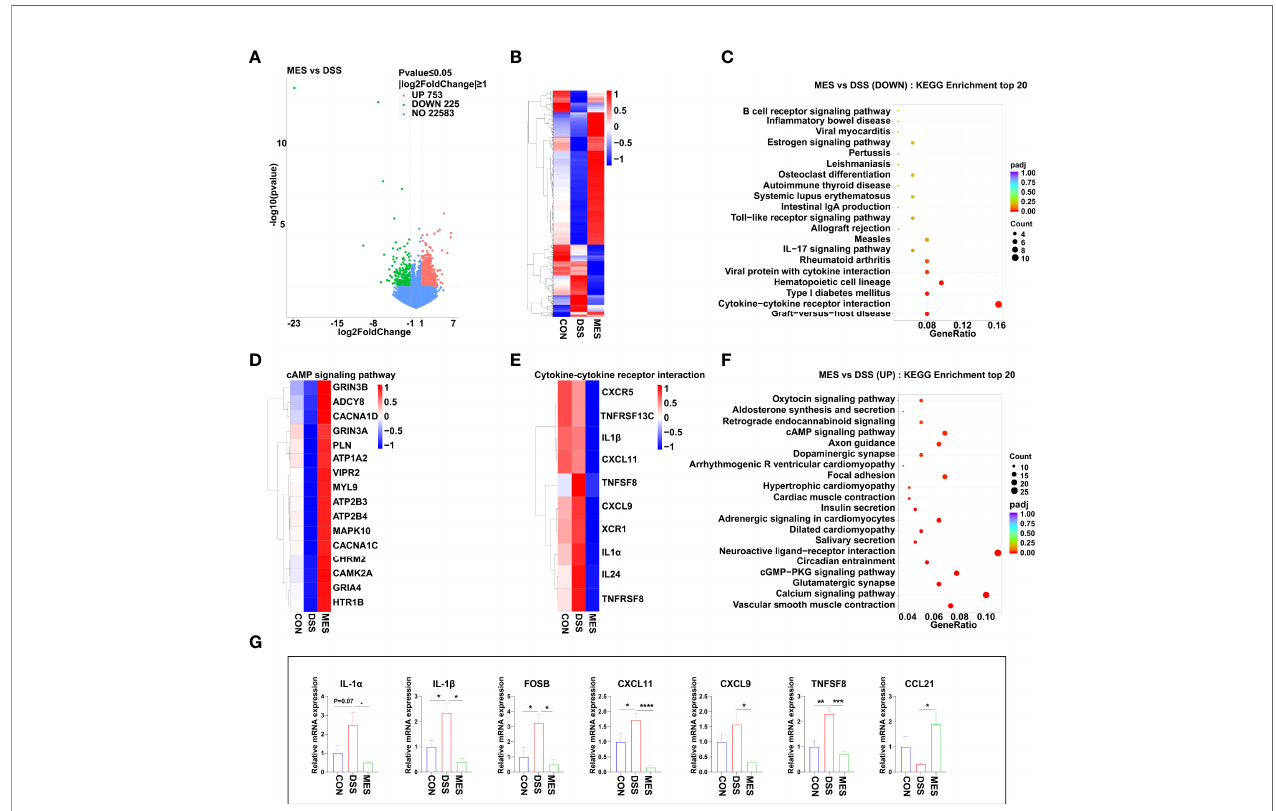
FIGURE 2 | MES suppresses immune responses in piglets with DSS-induced colitis. (A) Volcano plot of DEGs between DSS and MES groups. The X-axis represents the fold change in the expression of DEGs, and the Y-axis represents the statistical signi fi cance of the fold change. Each point represents a DEG. (B) Cluster heatmap of DEGs; top 20 KEGG annotation of (C) downregulated and (F) upregulated DEGs. The numbers of DEGs in each pathway are counted, and the KEGG gene ratio and adjusted P -values are acquired by hypergeometric distribution test. Heatmap of DEGs enriched in cAMP signaling pathway-related KEGG pathways (D) , cytokine – cytokine receptor interaction (E, G) Relative mRNA abundances of IL-1 a , IL-1 b , CXCL11, CXCL9, CCL21, FOSB, and TNFSF8 validated by RT-qPCR. Values were means ± SEM (n = 6 per group). * P < 0.05, ** P <